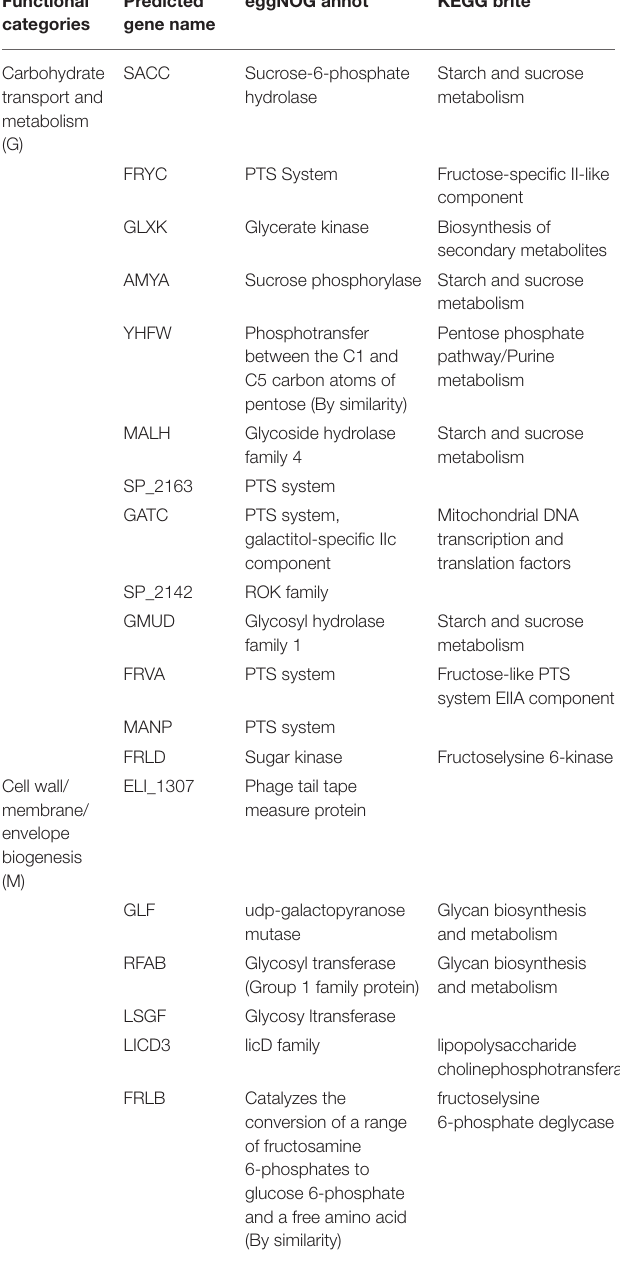
TABLE 4 | EggNOG functional annotations of L. paracasei (GMNL-653). Functional